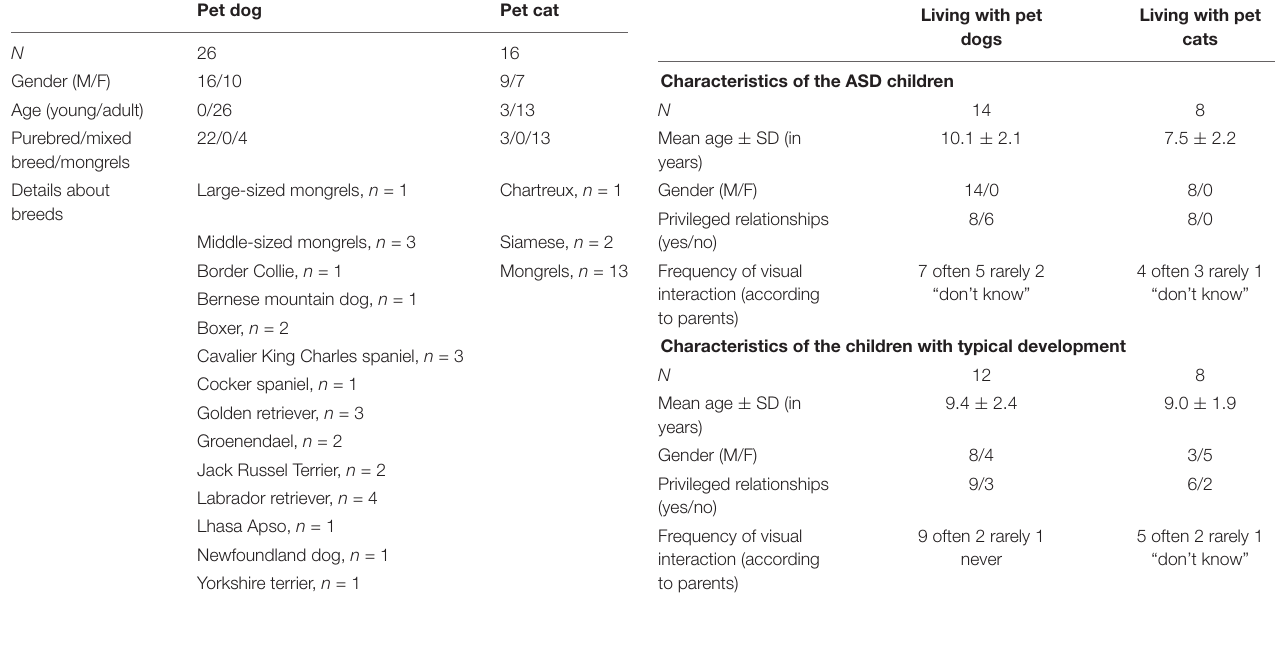
Population 1: Pet Dogs and Associated Children